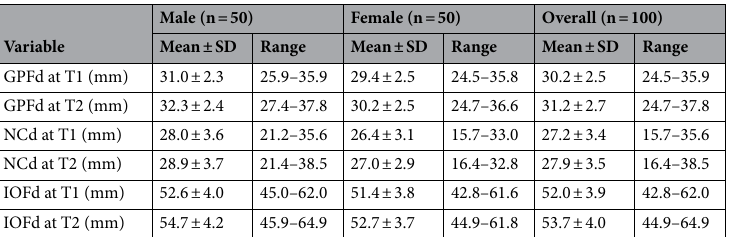
Table 2. Descriptive statistics of continuous dependent variables. SD: Standard deviation. GPFd: Transverse linear distance between greater palatine foramina. NCd: Transverse linear distance between nasal cavity walls. IOFd: Transverse linear distance between infraorbital foramina.